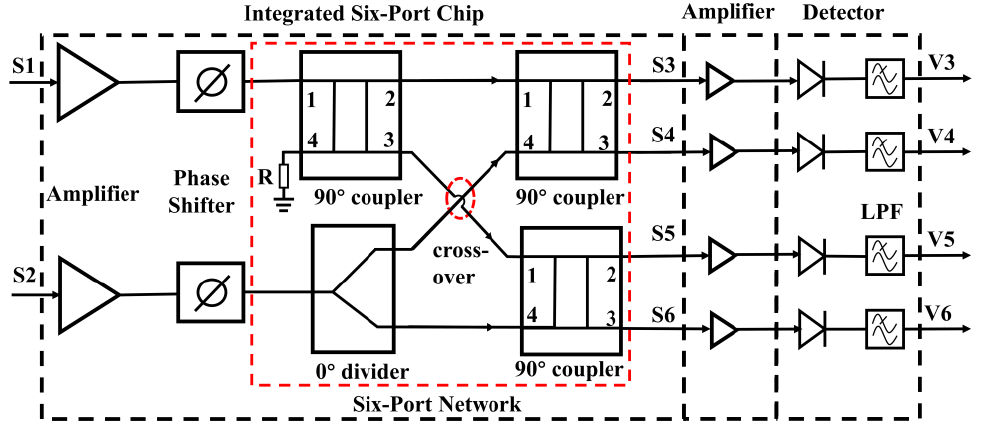
Figure 6. The circuit diagram of the designed correlator based on the integrated six-port chip.